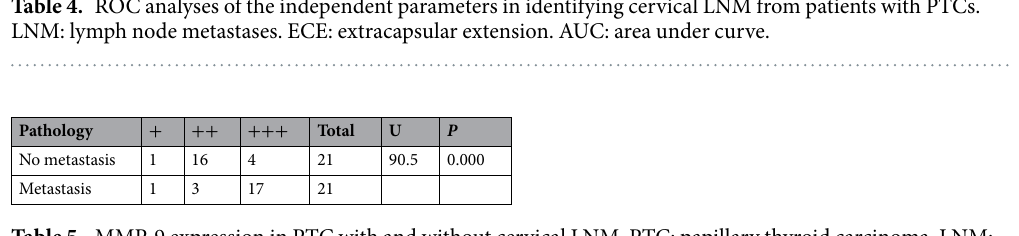
Table 5. MMP-9 expression in PTC with and without cervical LNM. PTC: papillary thyroid carcinoma. LNM: lymph node